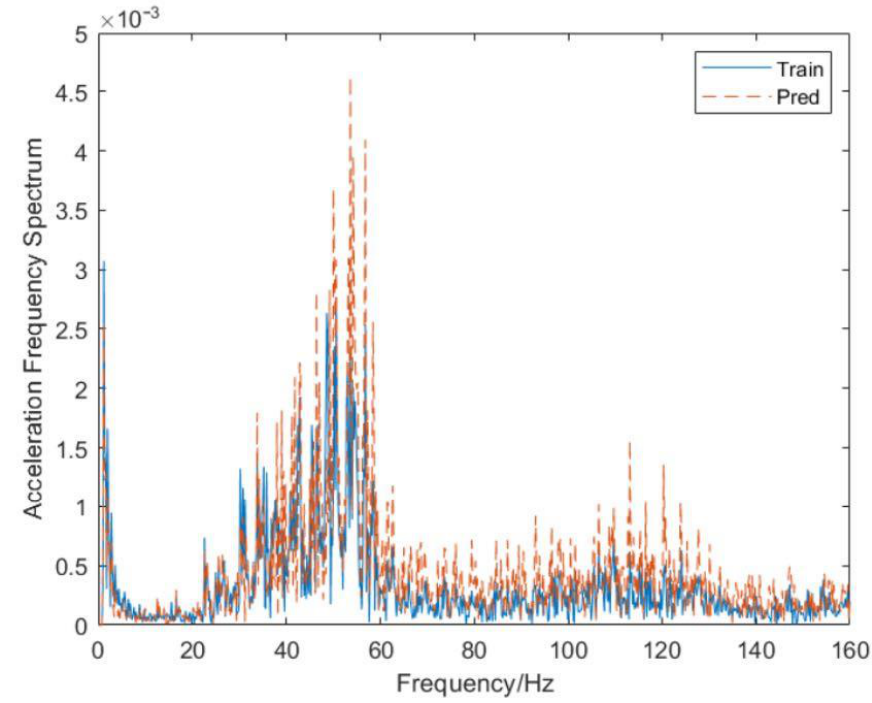
Figure 13. Comparison of acceleration frequency spectrum from Channel 7.